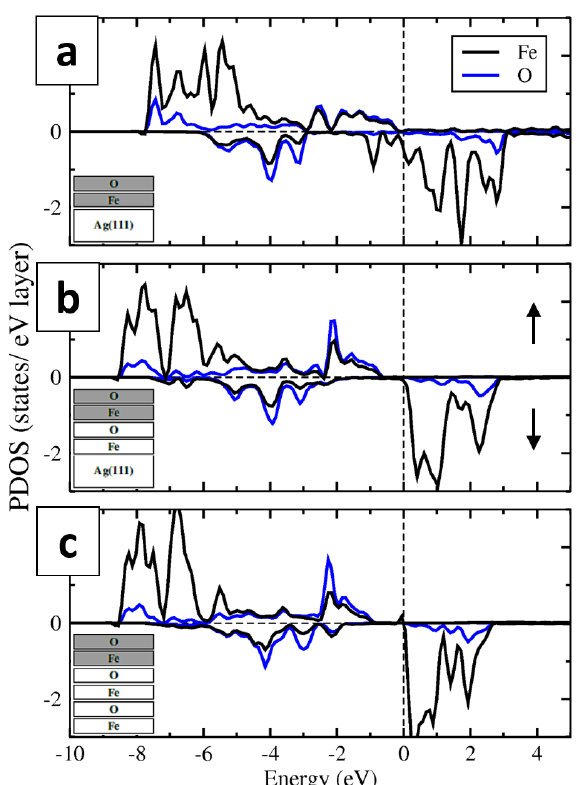
Figure 8. Partial densities of electronic states (PDOS) of a FeO(111) monolayer on Ag(111) ( a ), second FeO(111) layer from a bilayer FeO(111) film on Ag(111) ( b ) and the top FeO layer from a free-standing 3-MLs-thick FeO(111) slab ( c ), resulting from PBE+U calculations.